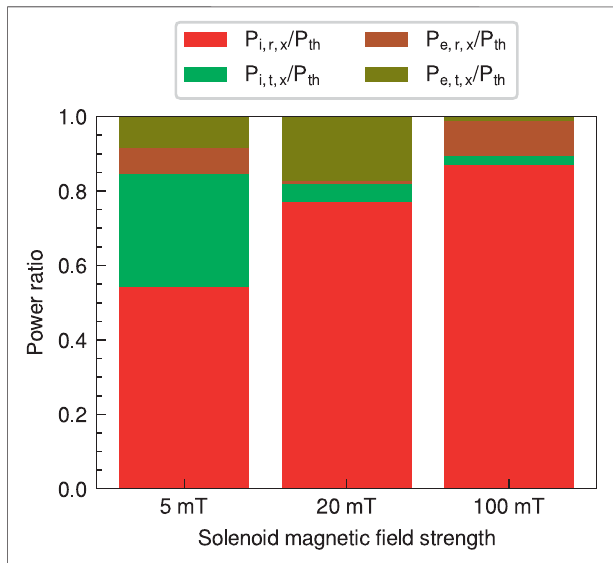
FIGURE13| Powerratiostotheplasmapowercontributingtothethrust P th in the magnetic nozzle RF plasma thruster for the three magnetic fi eld strengths of 5 (a left bar), 20 (a center bar), and 100 mT (a right bar). The de fi nitions of energy losses are described in Table 1